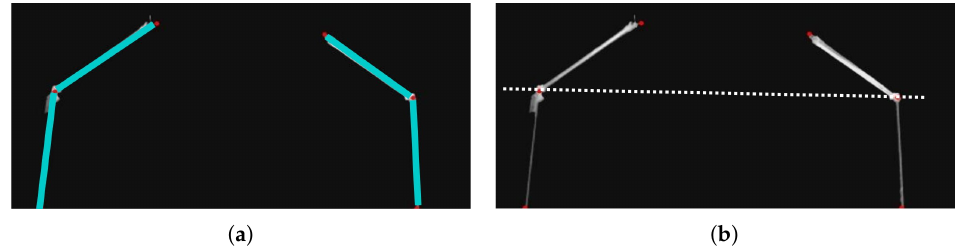
Figure 1. Checking deflection angle (adapted from [15]): ( a ) lines detection; ( b ) establishing base plane and computing deflection